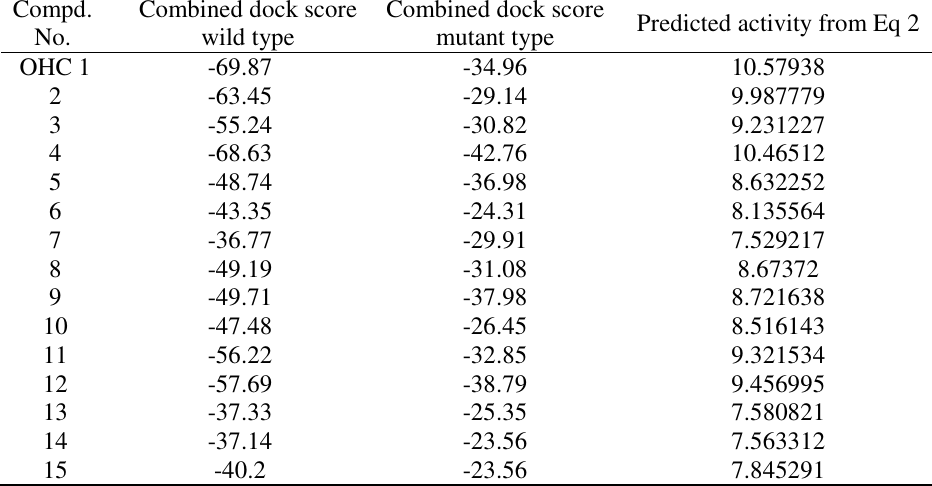
Table 4. Combined dock score and predicted activity of novel tetrahydroxy molecules Compd.